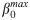
Effects of the Kinase Activity on Duration Robustness in the Heinrich Model.(A, B) Duration, ϑ, as a function of β0 and β1 with varied α0. Different lines indicate ϑ for different α0 values as given by the inset box in (B). Circles and diamonds represent β0max and β1max, respectively. (C) βimax as a function of α0. A solid line and a dashed line are β0max and β1max, respectively. The circles and the diamonds correspond to these symbols in (A) and (B). (D, E) Duration, ϑ, as a function of β0 and β1 with varied α1. (F) βimax as a function of α1. Same colors, lines and symbols are adopted as (A, B, C).